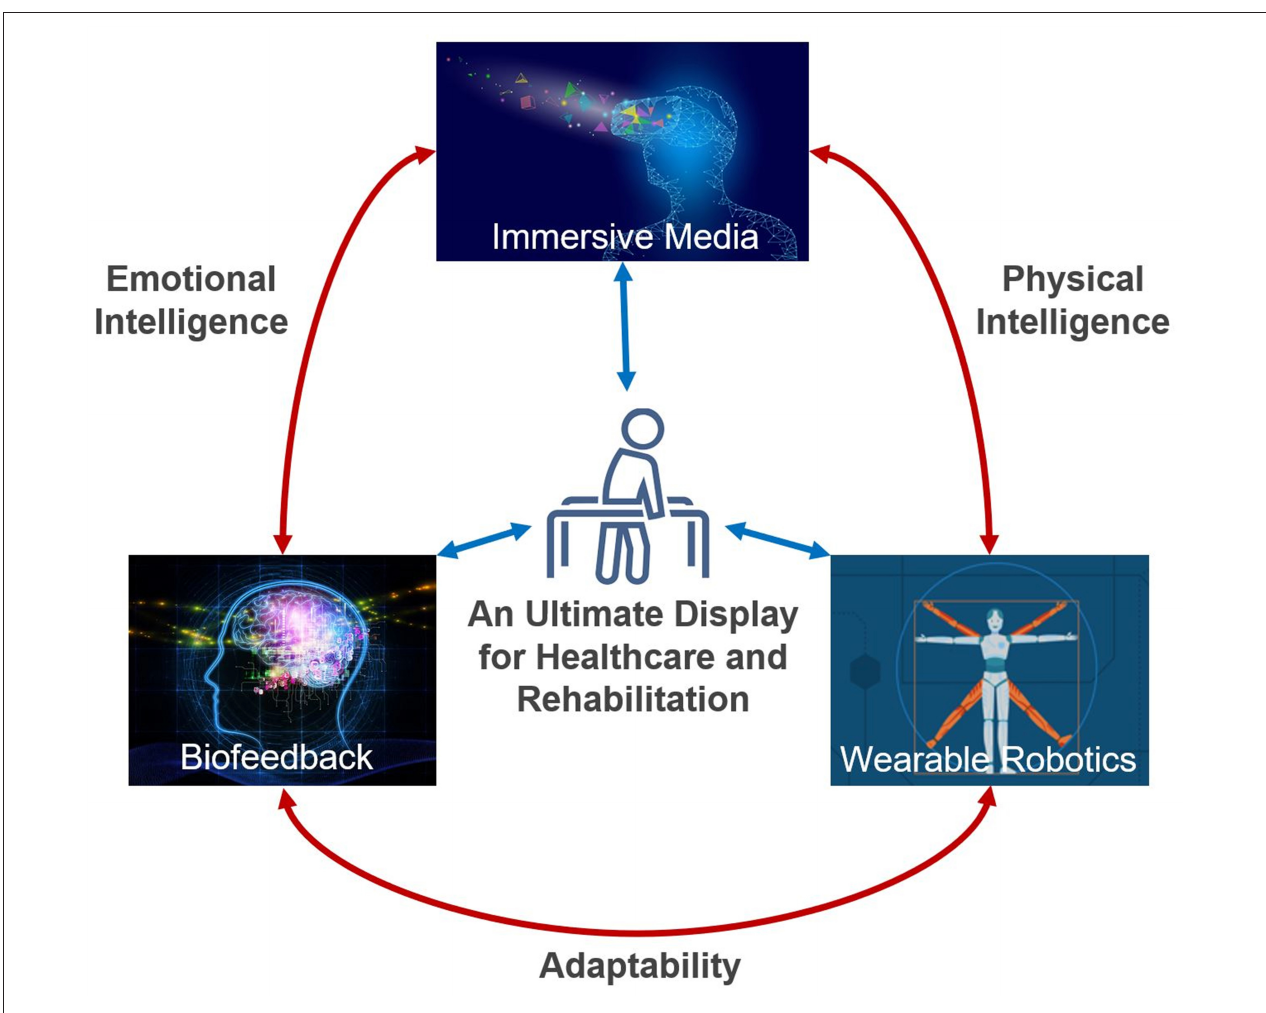
FIGURE 1 | Components of the theoretical ultimate display augmented for rehabilitation. Areas and some of their synergies through immersive media, wearable robotics, and biofeedback. Elements of wearable robotics enable automated tracking of user progression. Physical intelligence examples include haptic stimulation, physical assistance, and positional sensing informed between the virtual experience and the wearable. Emotional intelligence examples include personalizing iVR stimuli by arousal response and calibrating the difficulty of iVR therapy based on heart rate. Adaptability examples include adjusting the physical assistance of wearable robotics and allowing for biometric input modalities to enable users of mixed ability to participate in the virtual